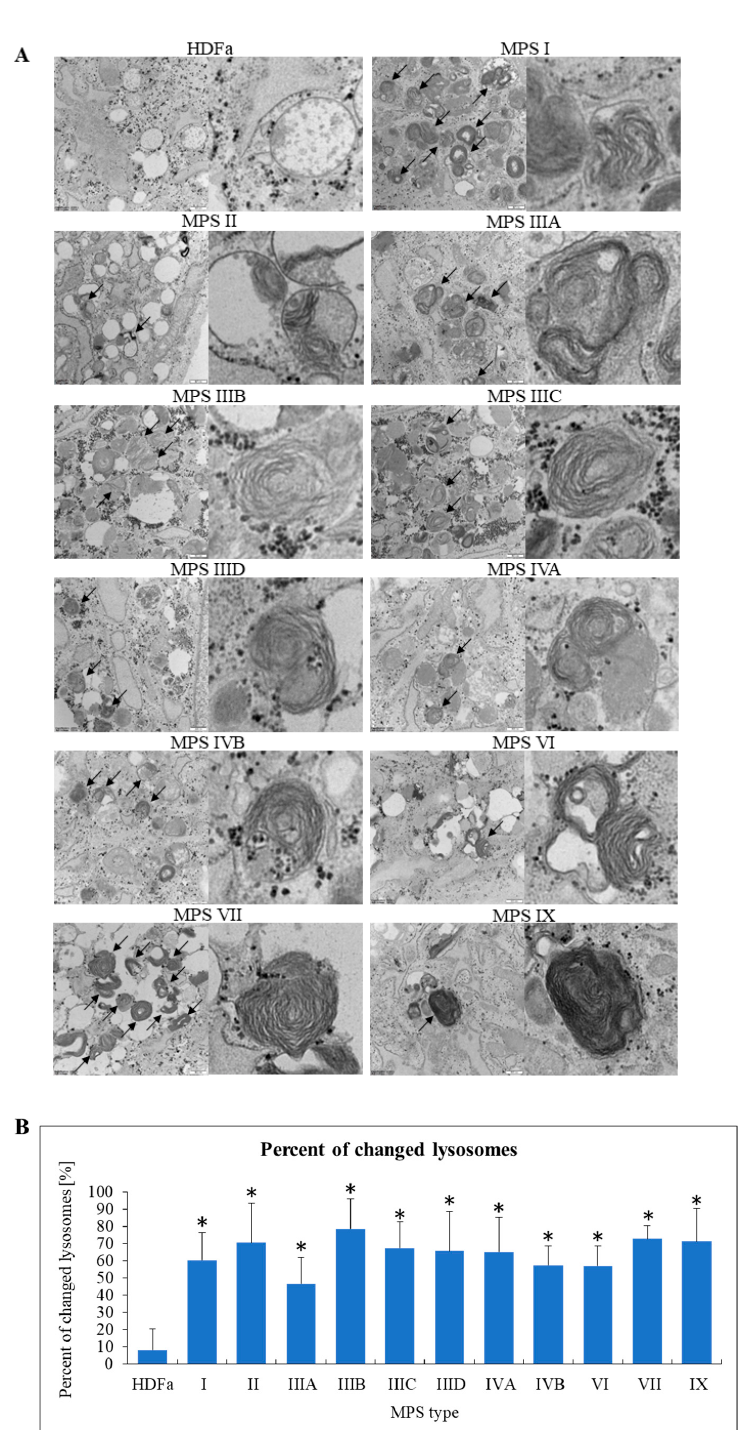
Figure 5. Morphology of lysosomes in MPS fibroblasts in comparison to control cells (HDFa cell line). Representative electron micrographs are presented in ( A ) (size bars represent 500 nm; arrows indicate changes in these structures). Quantification of changes in lysosomes is presented in ( B ). Mean values ± SD are presented, with asterisks representing statistically significant ( p < 0.05) differences relative to the HDFa control.